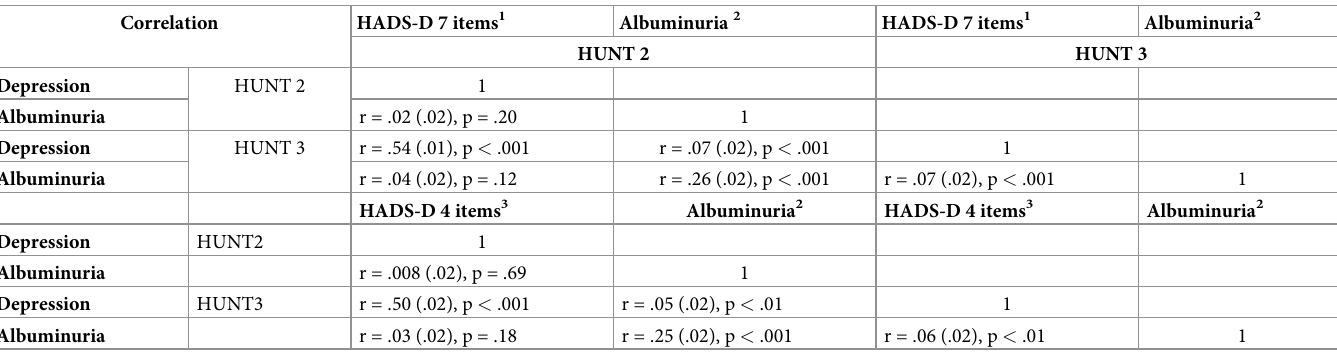
Table 2. Spearman correlation between the depression symptoms and albuminuria �